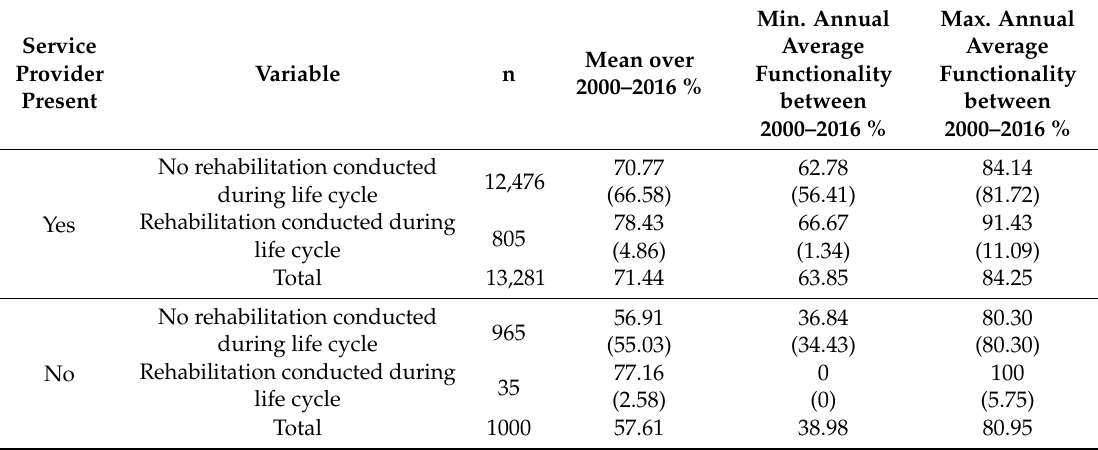
Table 1. Functionality at the time of audit of Afridev hand pump boreholes installed between 2000–2016, evaluating the influence of service providers present and rehabilitation conducted during the life cycle. Percentage values in parentheses are in relation to the total